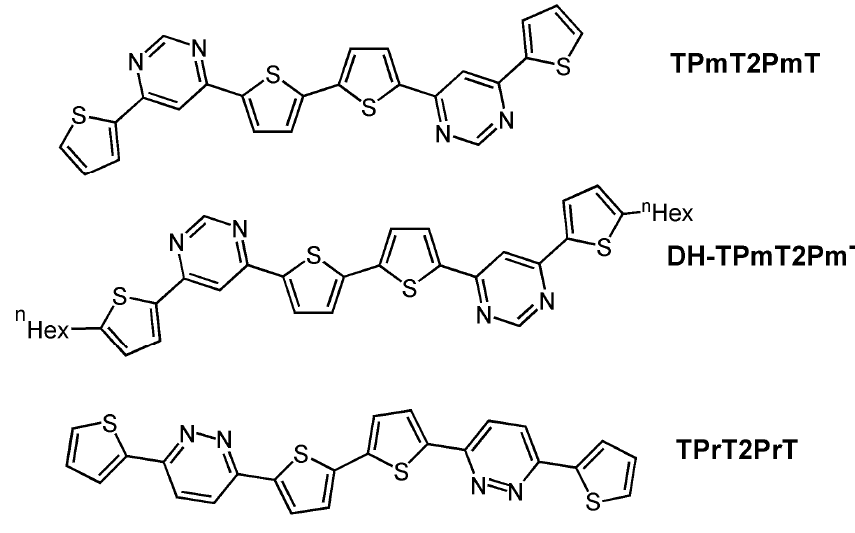
Figure 5. Chemical structures of thiophene-diazine oligomers.